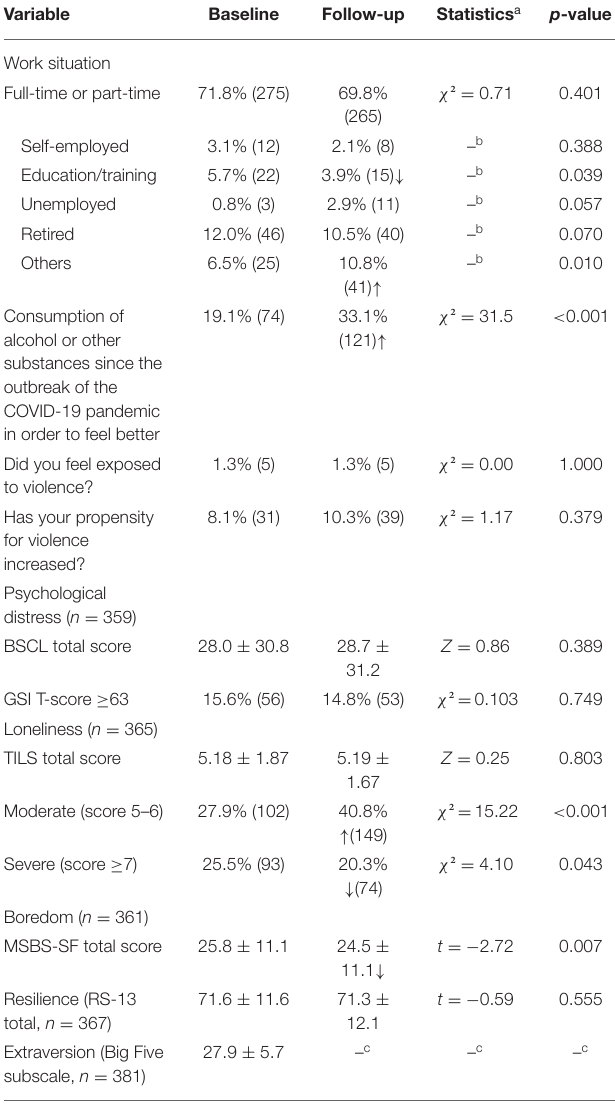
TABLE 1 | Sociodemographics, COVID-19-related variables, and psychological variables among 384 adults from the general population in the course of